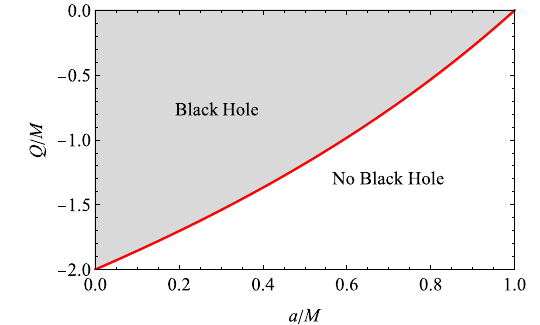
Fig. 1 The parameter plane for ( a , Q ) of the rotating metric, and the thin line separates black holes from configurations without an event